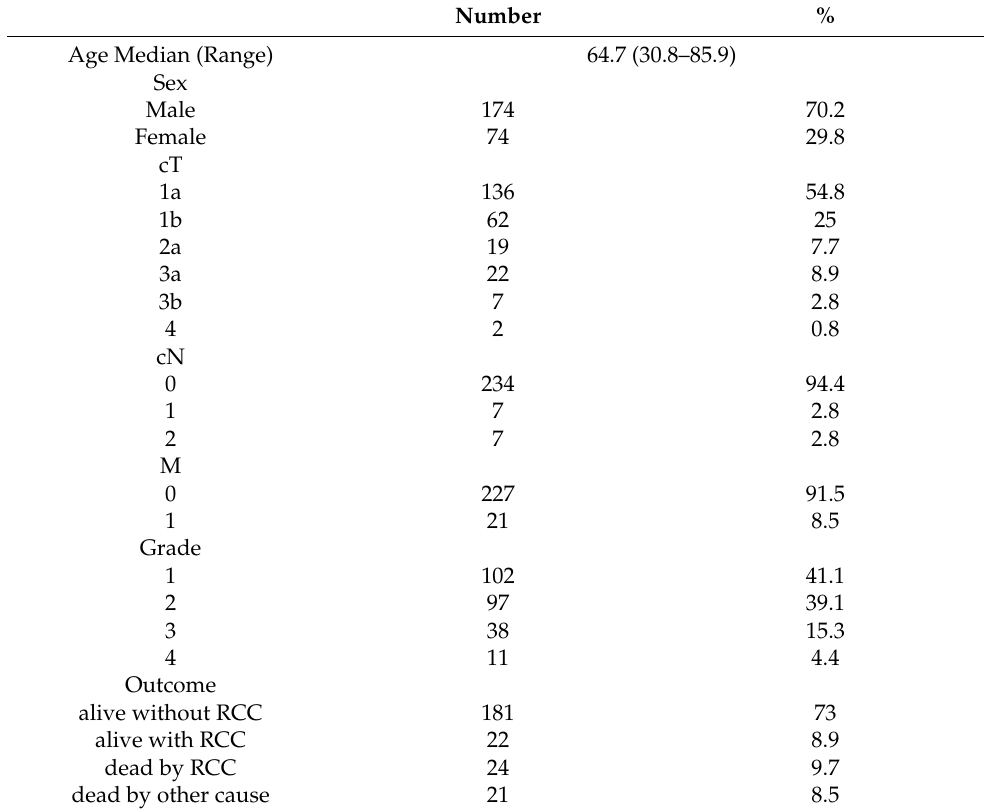
Table 1. Patient